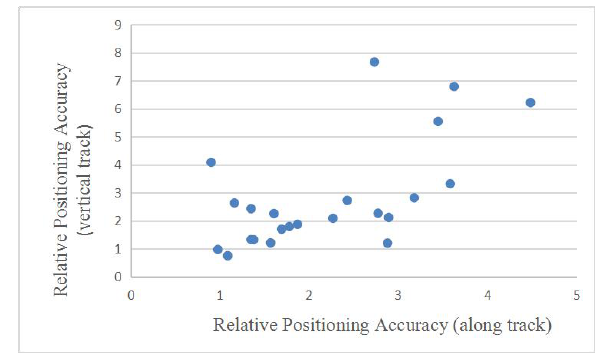
Figure 3. Absolute positioning accuracy distribution on plains (blue columns ), hills (yellow columns), and mountain (red columns) terrain